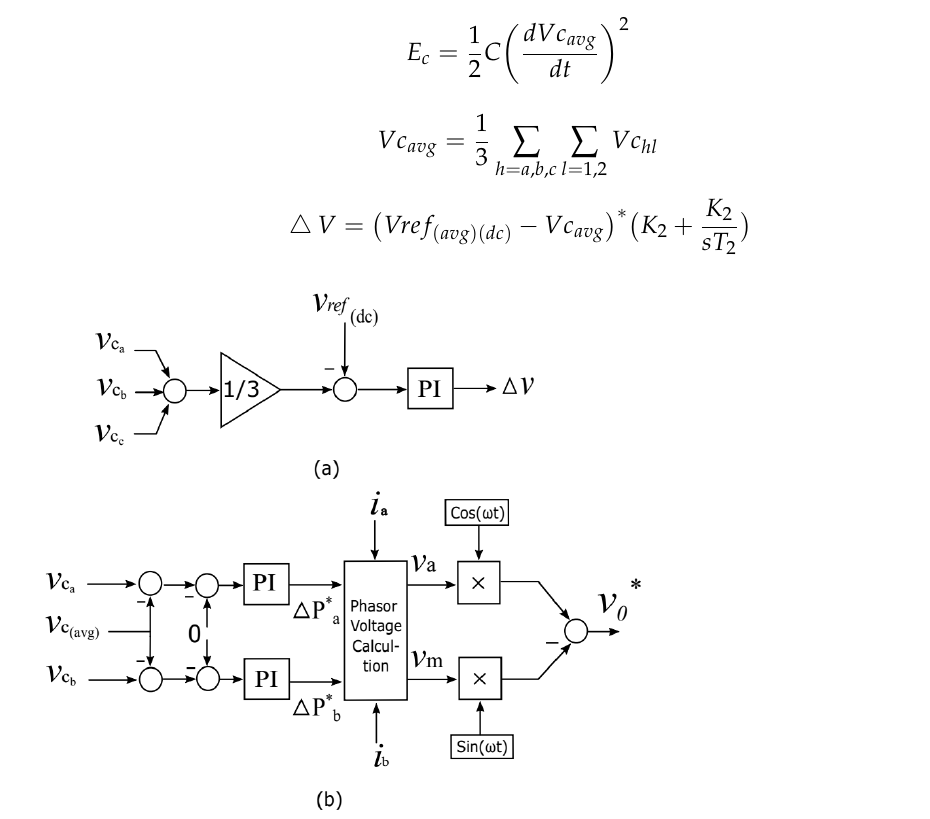
Figure 9. Voltage control loop. ( a ) Average-mode DC-link capacitor voltage control loop. ( b ) Difference-mode DC-link capacitor voltage control